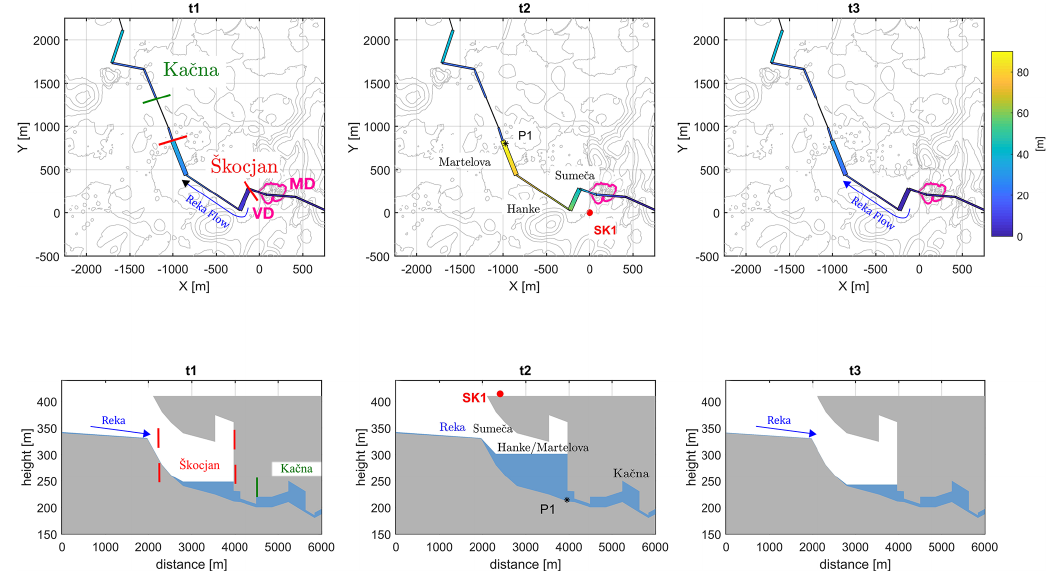
Figure 4. Water distribution in the caves at three snapshots (t1, t2 and t3; refer to Fig. 2b). For each time step, a cross-section and a plan view of the water levels in the caves are displayed. Note that in the cross-sections the vertical scale is exaggerated by a factor of about 10, and the cross-sections are plotted from east to west. The colour code is proportional to the water level height in the conduits. The contours of the DEM are shown in grey. The origin of the reference system is centred on the gravimeter SK1 (red dot in snapshot t2). The cross-section follows the path of the channel system, marked in the plan view. The distance is referred to the first node approximating the Cerkvenikov Mlin position. In the t1 snapshots the limits of the Škocjan cave system are displayed through the red lines; beginning of Kaˇcna cave system in green. SK1: gravimeter; P1: diver in Martelova. The coalescent dolines, Mala Dolina (MD) and Velika Dolina (VD) are shown with the purple